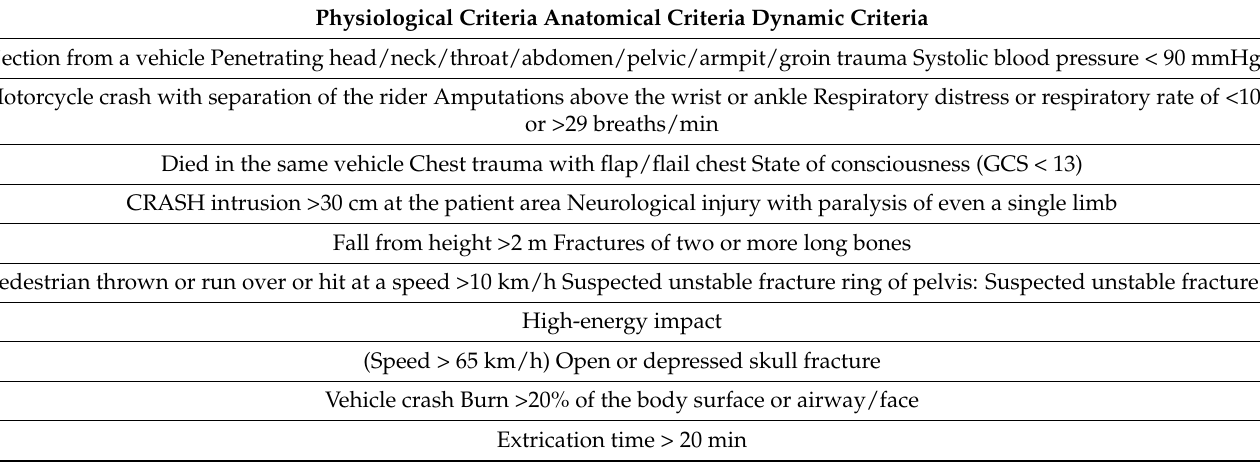
Table 1. Triage criteria for severe trauma. Physiological Criteria Anatomical Criteria Dynamic